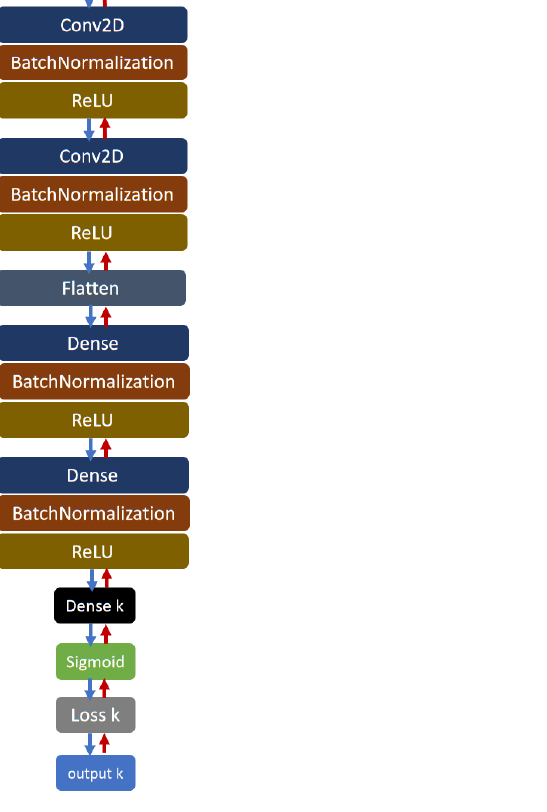
Figure 8. CNN architecture of an independent classifier. Table 2. Design specification of an independent